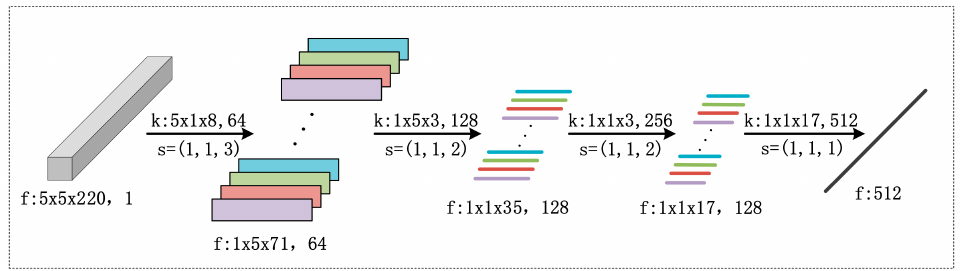
Figure 2. Illustration of the adopted 3D-CNN architecture for the feature extractor sub-network, together with parameter settings (such as dimension of feature (f), convolution kernels (k) and